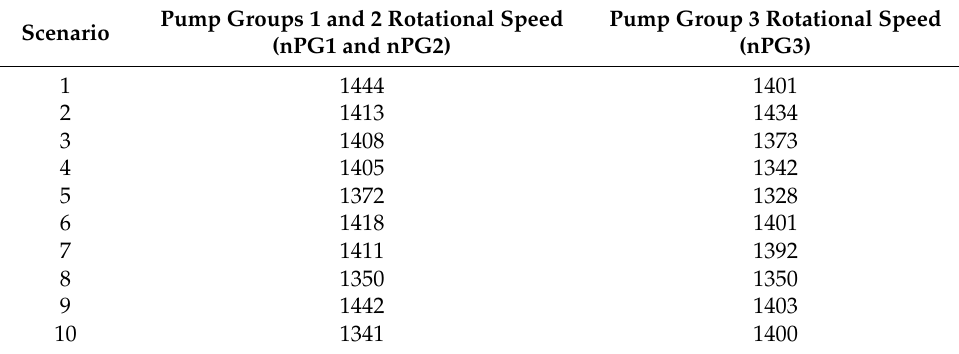
Table 5. Scenarios for the variation of Pump Rotational Speed.